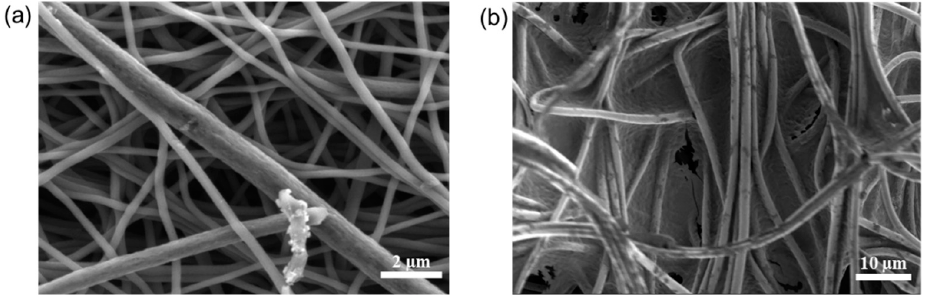
Figure 9. SEM images of ( a ) mpCNF and ( b ) mpCPAN.